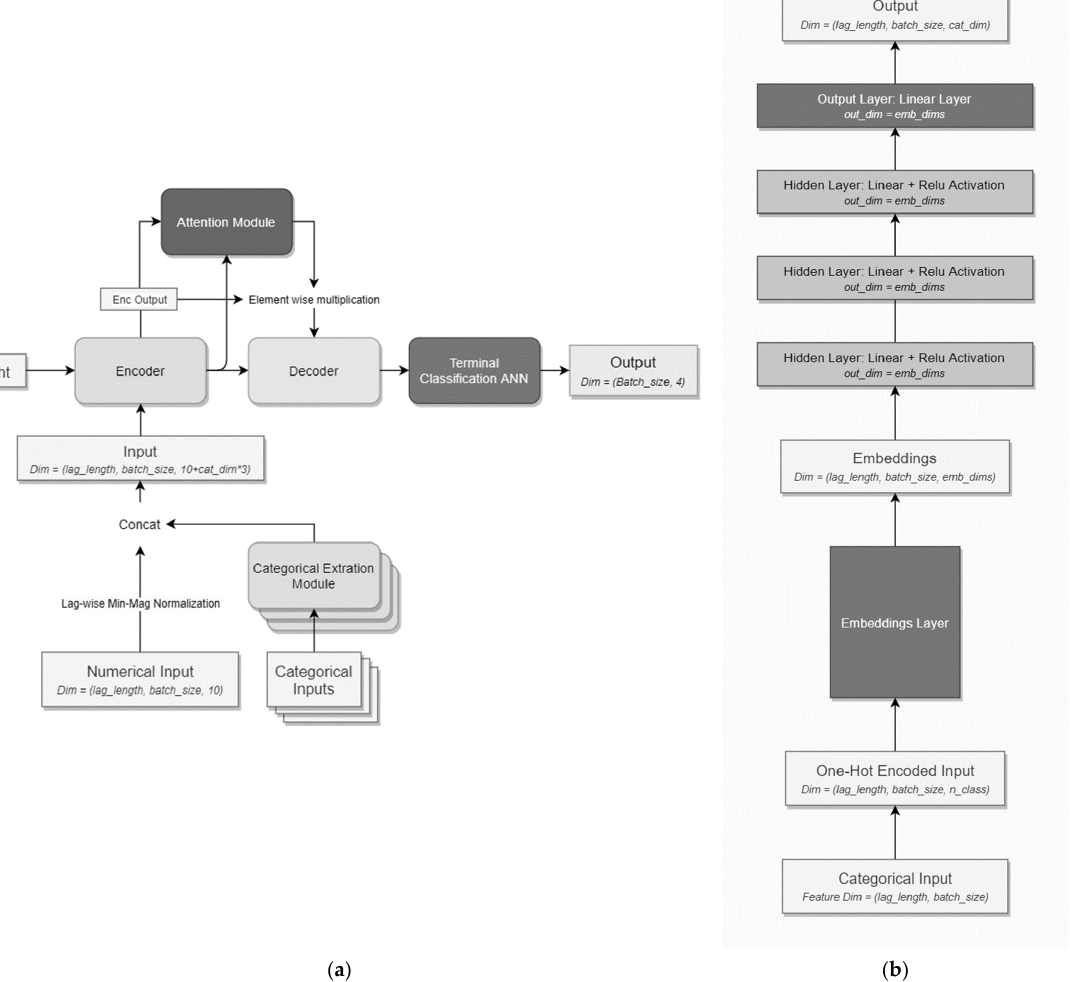
Figure 1. ( a ) Encoder-Decoder with Self-Attention Model Framework; ( b ) Specifications of Categorical Feature Extraction Module.